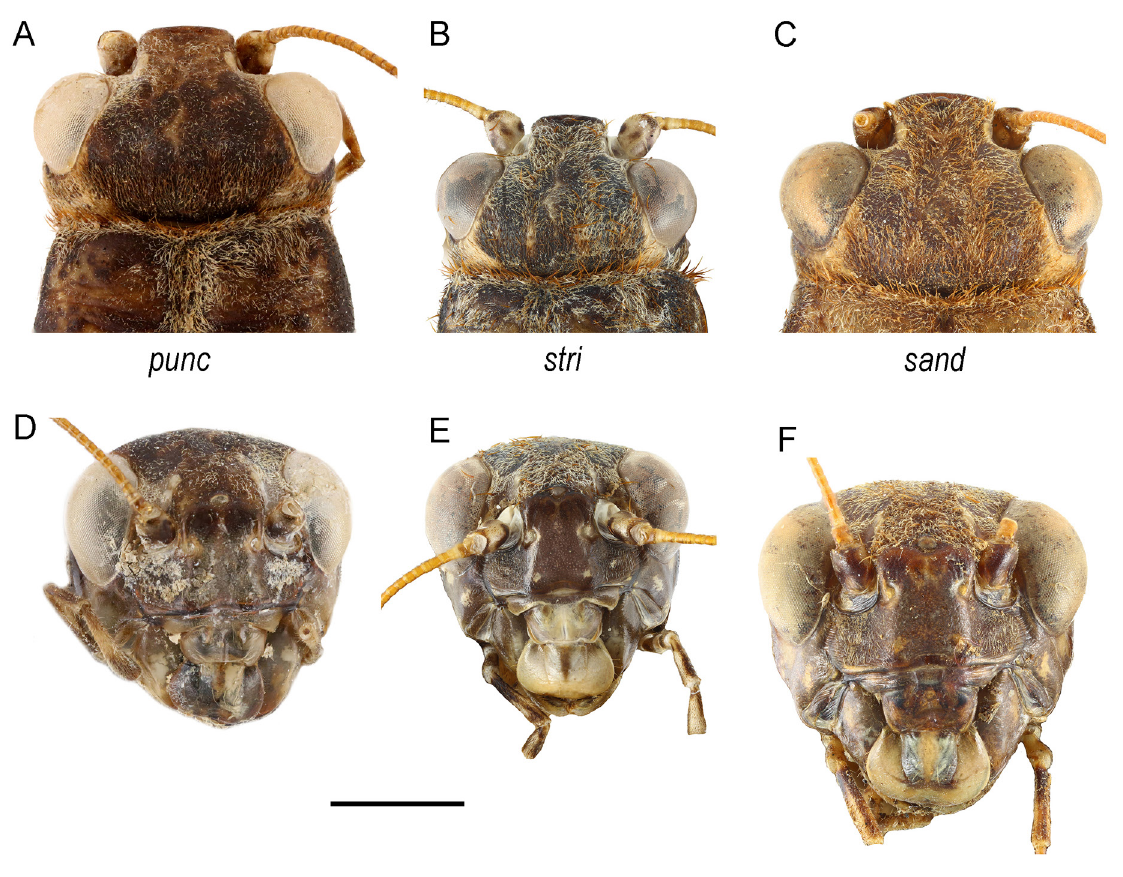
Fig. 5. Head in dorsal view (A–C) and face in anterior view (D–F). A, D . Platybinthus punctatus (Brunner von Wattenwyl, 1898) gen. et comb. nov., syntype, ♀ (MNHN-EO-ENSIF1448). B, E . Platybinthus striolatus (Brunner von Wattenwyl, 1898) gen. et comb. nov., ♂ (ZIN). C, F . Platybinthus sandyi gen. et sp. nov., holotype, ♂ (MZB.ORTH.1786). Scale bar = 2